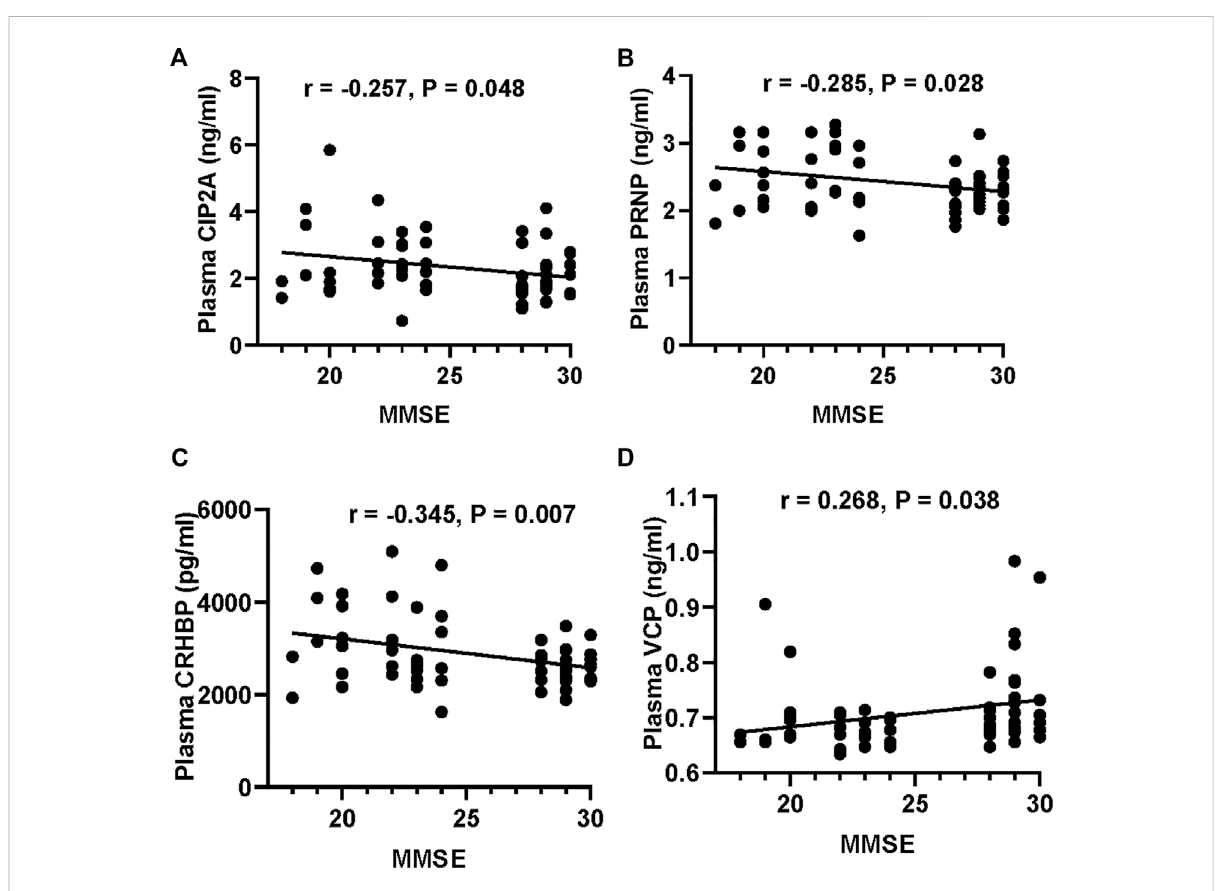
FIGURE 5 Correlation of the potential marker protein levels with MMSE. (A – D) Correlations between CIP2A or PRNP or CRHBP or VCP levels and MMSE scores.